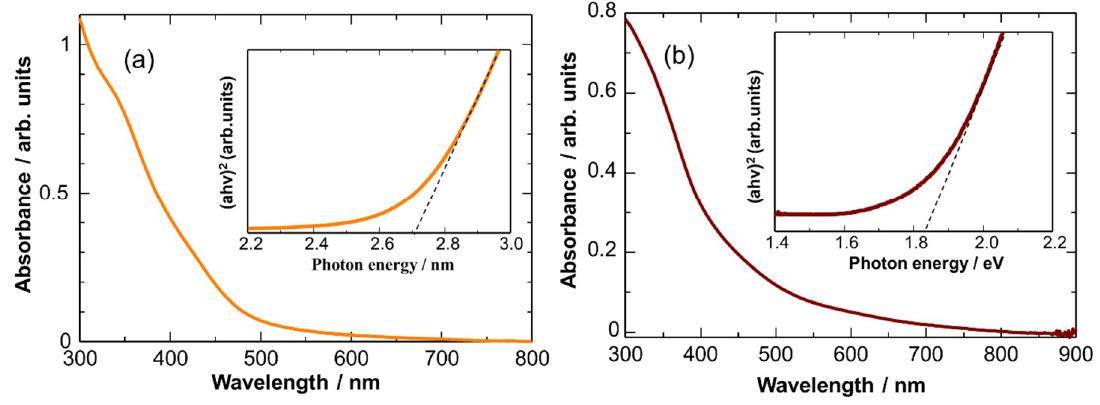
Figure 4. UV-vis absorption spectra of ( a ) Cu 2 O NCs and ( b ) CuO NCs in toluene. Insets show the corresponding Tauc plots.